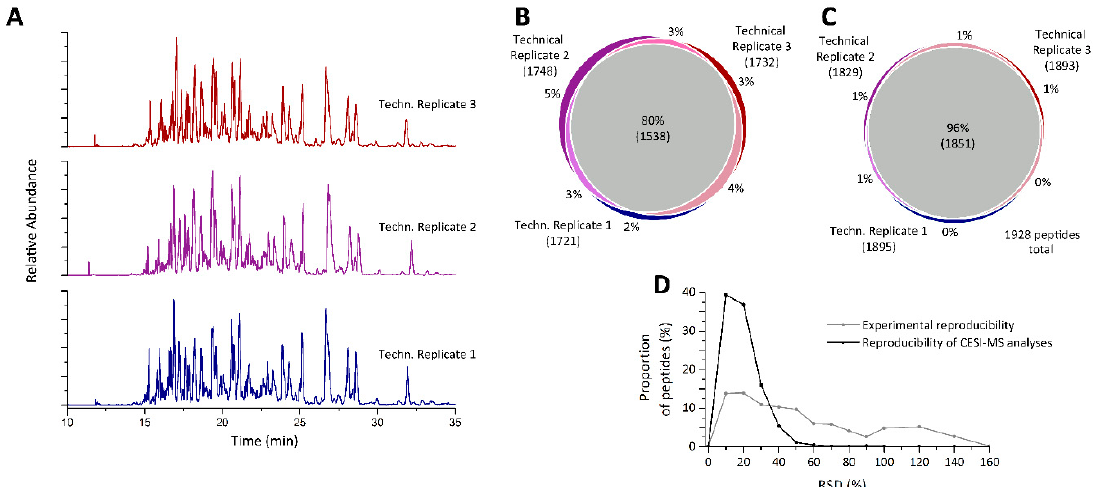
Figure 2. Technical reproducibility of CESI-MS analyses when analyzing a digested SiO 2 NM protein corona. ( A ) Base peak electropherograms of technical replicates, Venn diagrams of peptides ( B ) identified via MSMS and ( C ) detected as precursor mass in the three technical replicates. ( D ) Reproducibility of peptide quantifications shown as histogram of relative standard deviations.